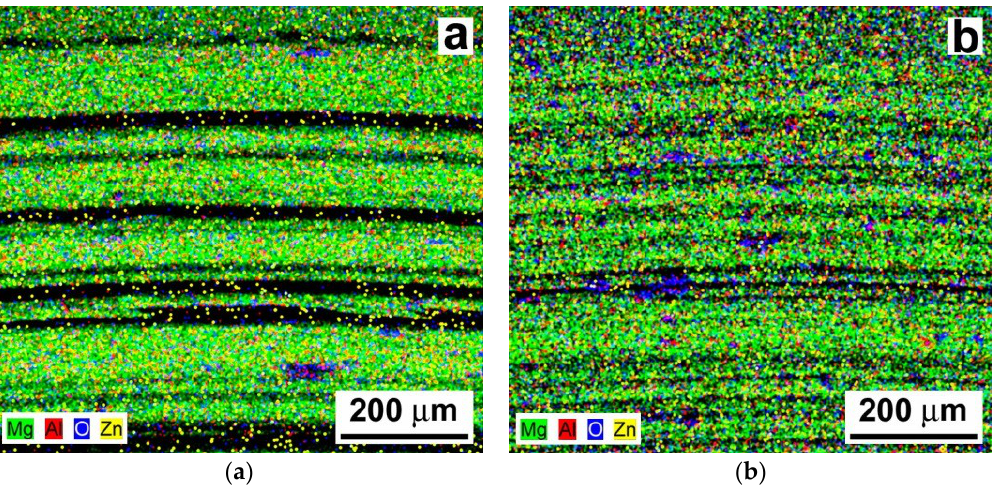
Figure 10. Energy dispersive X-ray (EDX) elemental maps from the wear track areas in AZ61 base material: ( a ) the laser untreated and ( b ) the laser treated material state.